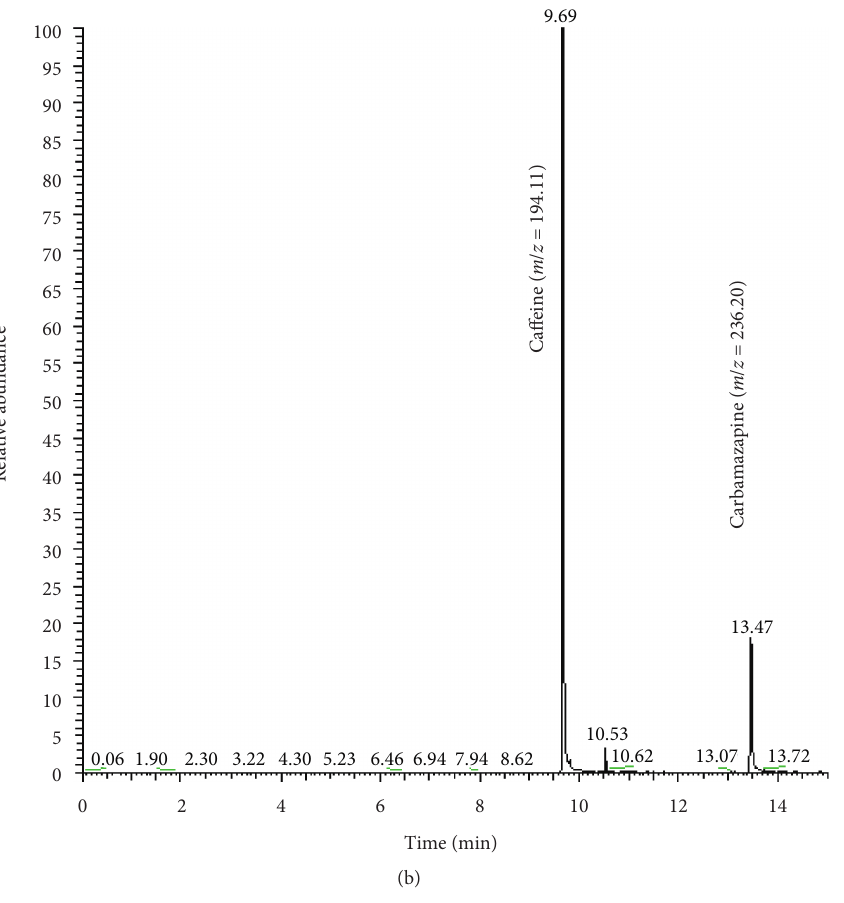
Figure 2: Representative chromatogram showing caffeine and carbamazepine (IS) peaks in the energy drink sample analyzed by the proposed GC-MS method: (a) total chromatogram and (b) selected ion chromatogram (concentration ≈ 10 μ Table 4: Concentration of caffeine in energy beverages collected from Saudi Arabian market, determined by the current GC-MS method. Energy drink sample